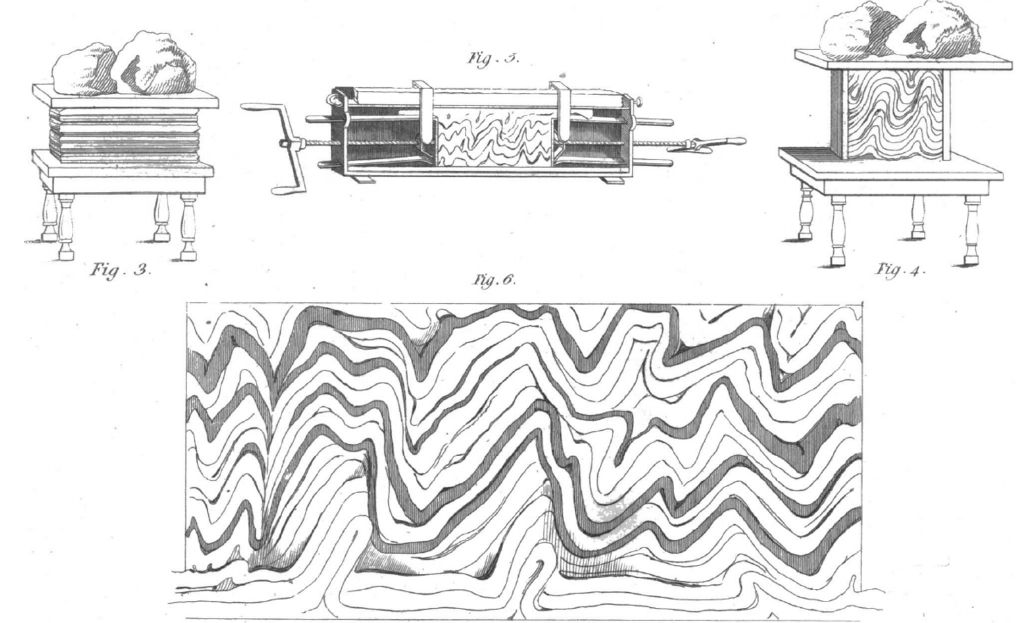
Figure 1. Original sketch of James Hall’s (1815) folding